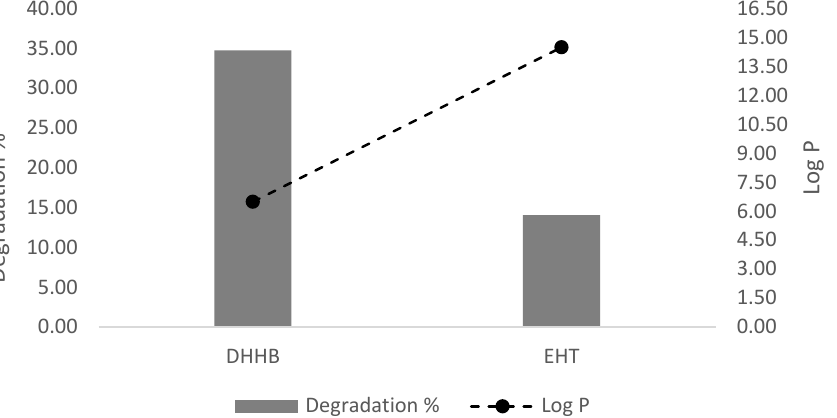
Figure 11. Comparison of DHHB and EHT degradation in relation to Log P values. The degradation is directly proportional to the hydrophilicity of the filters.